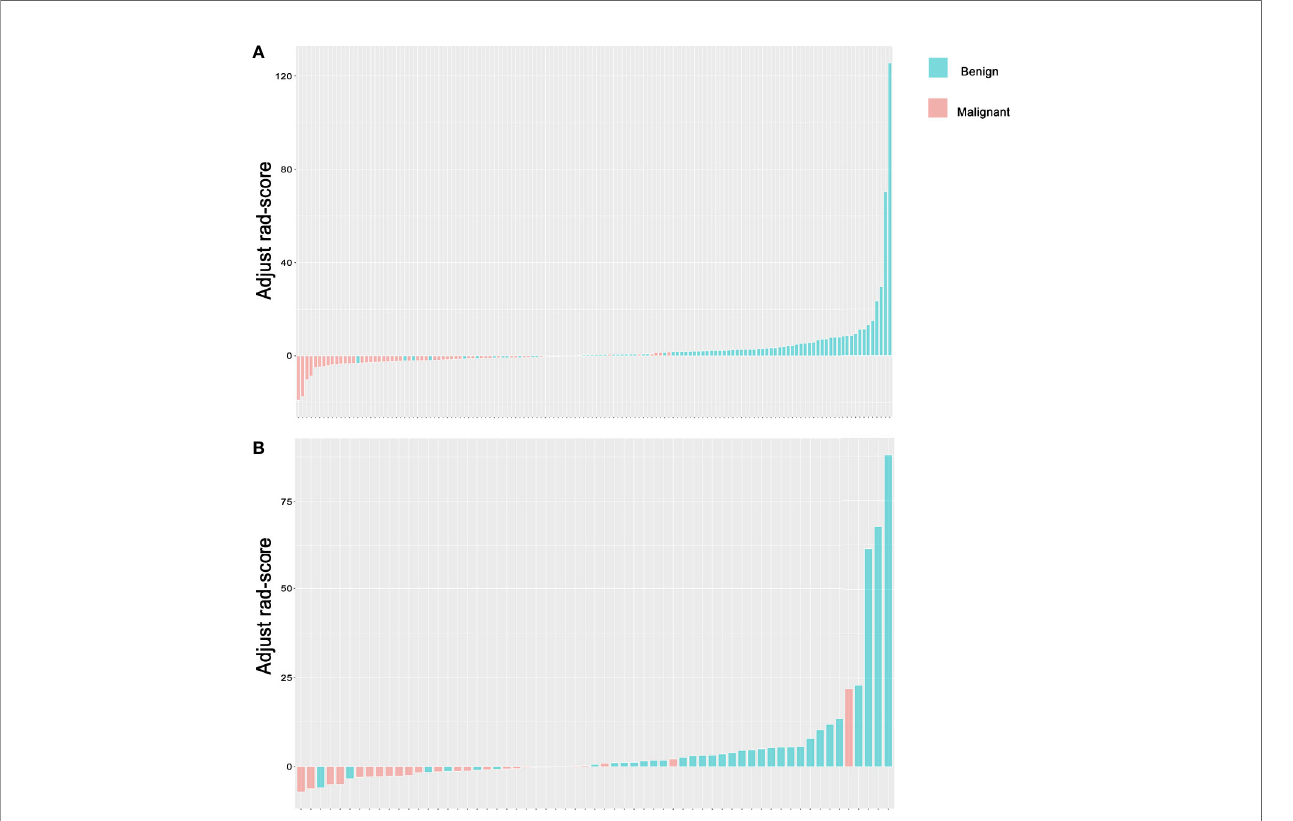
FIGURE 6 | Rad-score for lymph nodes. (A) Rad-score for every LN in the training set. (B) Rad-score for every LN in the test set. The y-axis refers to the Rad-score minus the optimal cutoff value. Up and down bars refer to the classi fi ed malignant and benign LNs, respectively. Blue and red bars refer to actual malignant and benign LNs, respectively. LN, lymph